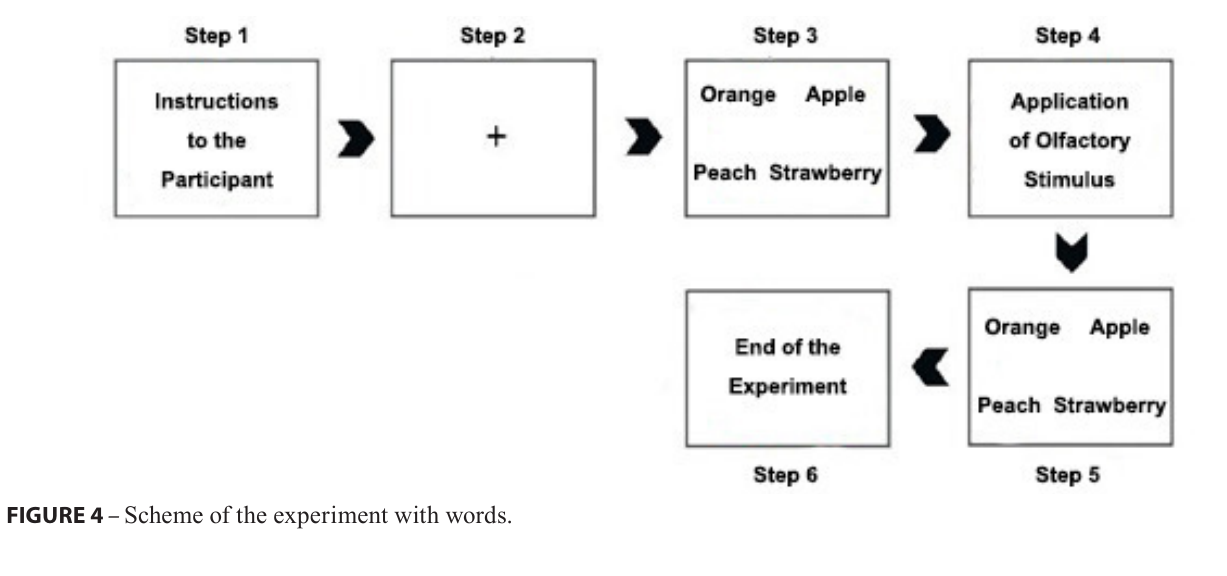
FIGURE 4 – Scheme of the experiment with